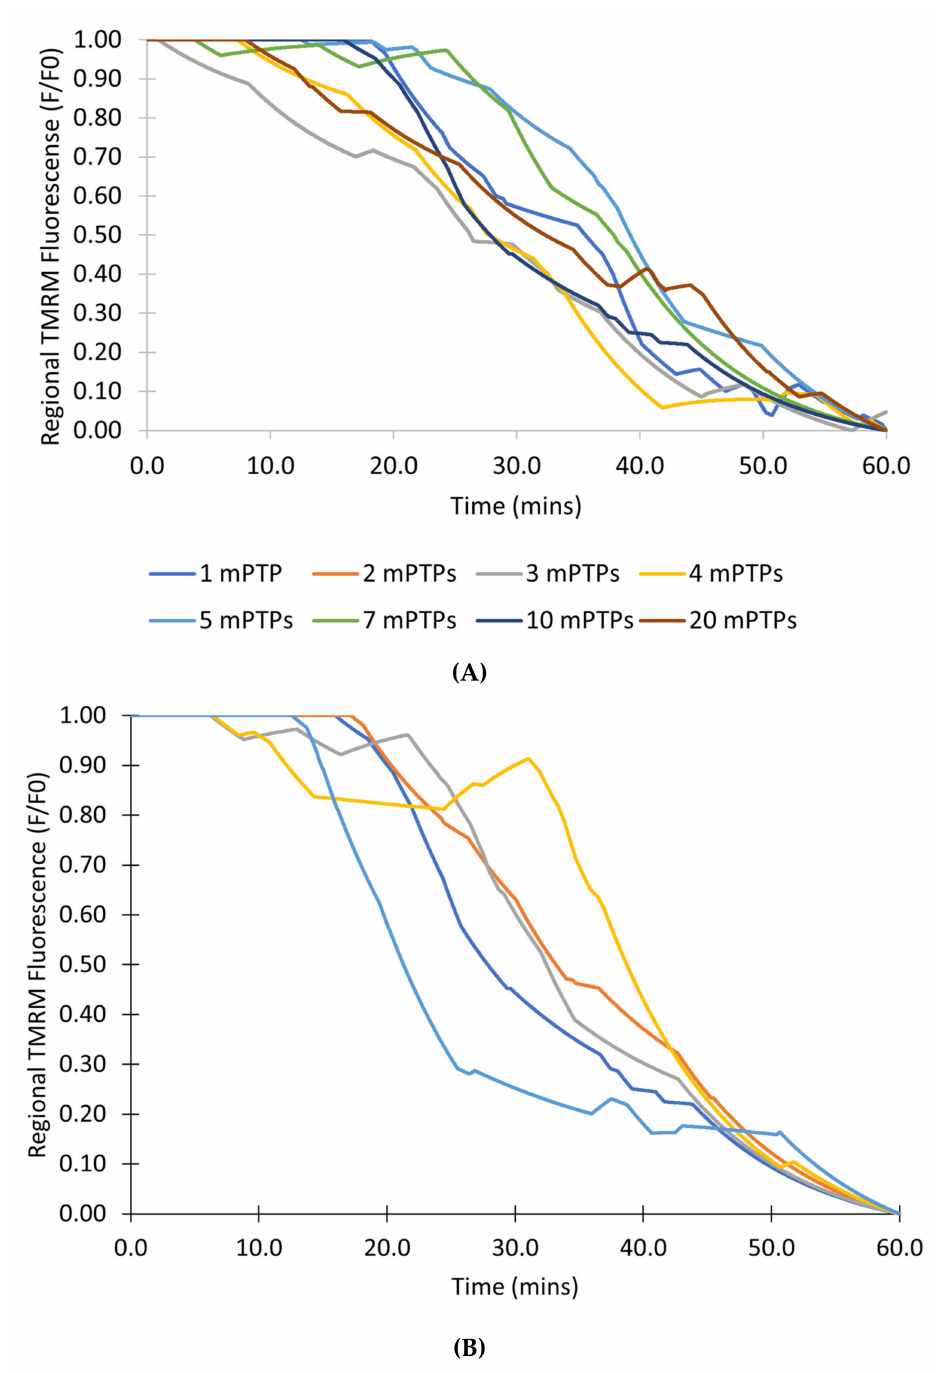
Figure 12. Simulation in the mPTP model with only transient states. ( A ) Simulations showing the average TMRM fluorescence from 100 mitochondria with 1, 2, 3, 4, 5, 7, 10, and 20 pores each. ( B ) Five simulations showing the average TMRM fluorescence from 5 mitochondria with 10 pores